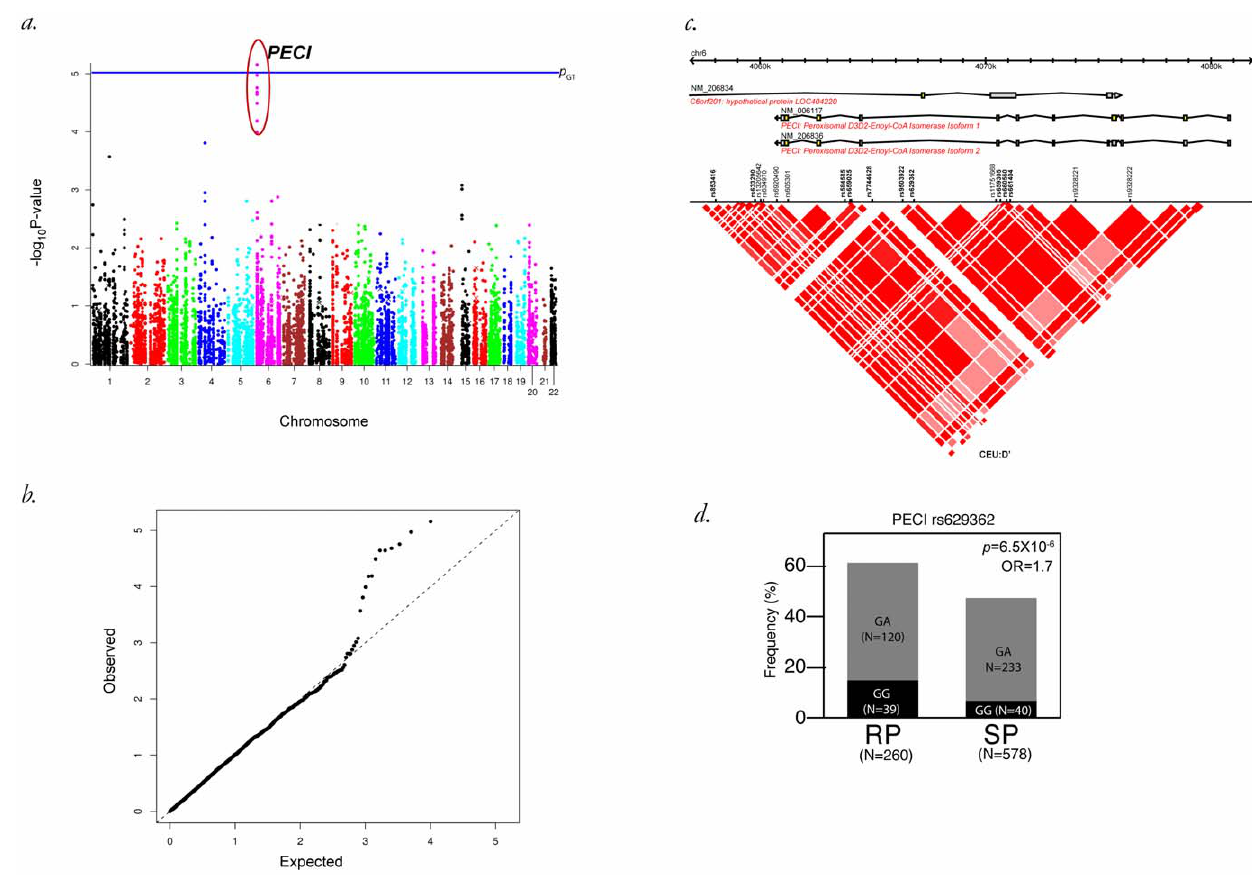
Figure 1. Association of SNPs within the PECI gene region of chromosome 6 with AIDS 1987. A Manhattan plot (a.) and corresponding QQ plot (b.) for 10012 SNPs in NEMP genes showing the additive model that implicates SNPs in the PECI gene region exceeding the GT significance threshold (horizontal line, 9.2 6 10 2 6 ). A gene view of PECI showing SNPs tested and corresponding linkage disequilibrium as inferred by D’ between SNPs (c.) and a bar-plot of genotypes of PECI versus the AIDS-1987 diagnosis in years past seroconversion (d.) are shown.